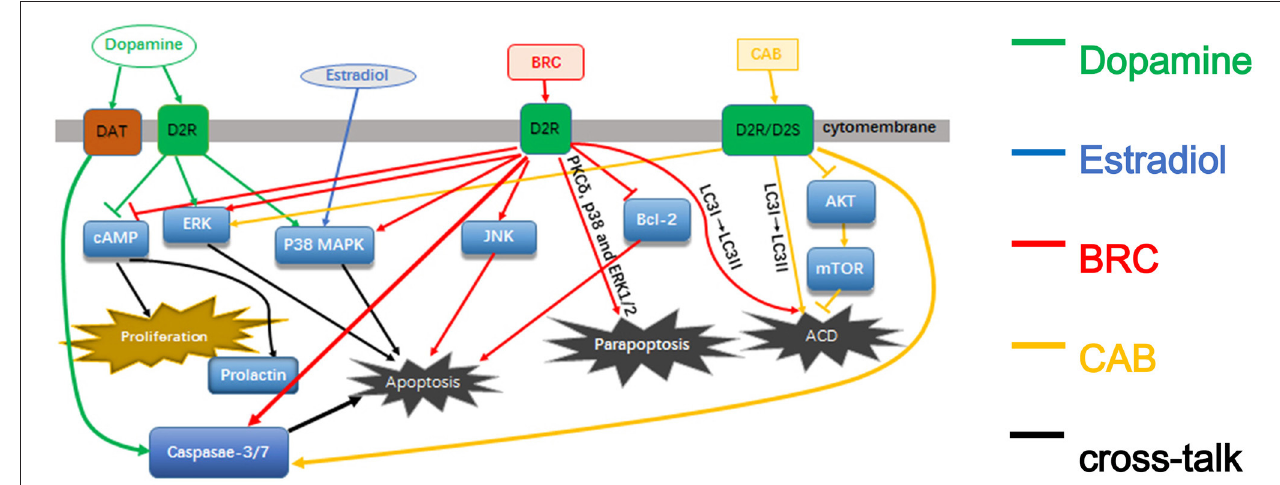
FIGURE 1 | The pathways of dopamine and dopamine agonists in